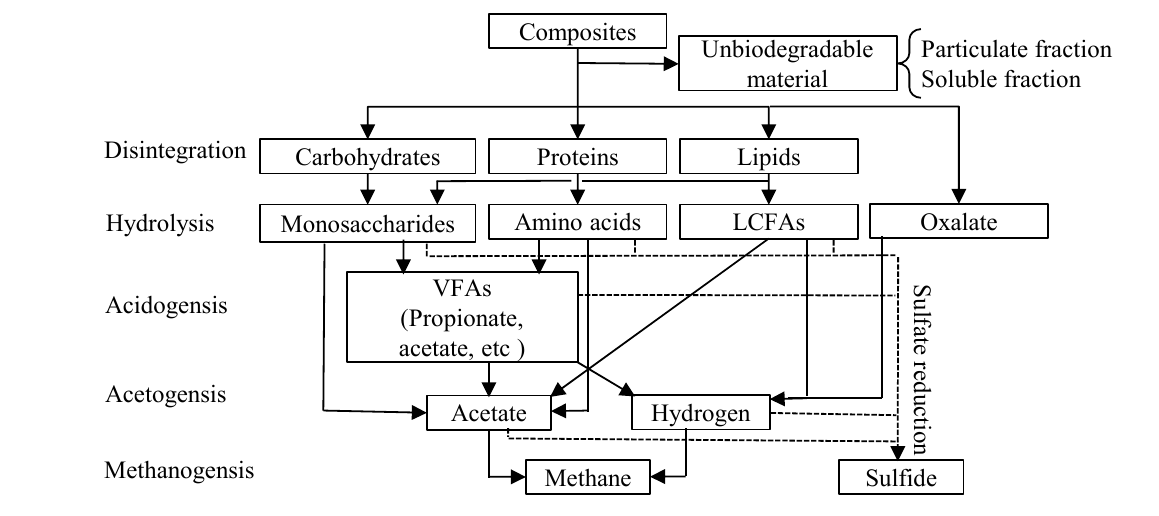
Figure 3. Organic decomposition of anaerobic fermentation including sulfate reduction, —: methane production route, ---: sulfate-reduction route.